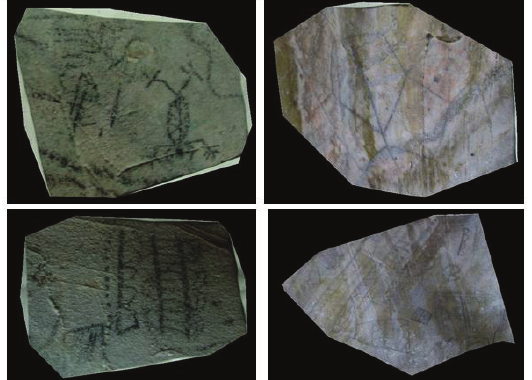
Figure 7: The visualization of the ancient paintings as the output from the terrestrial-based close-range photogrammetry